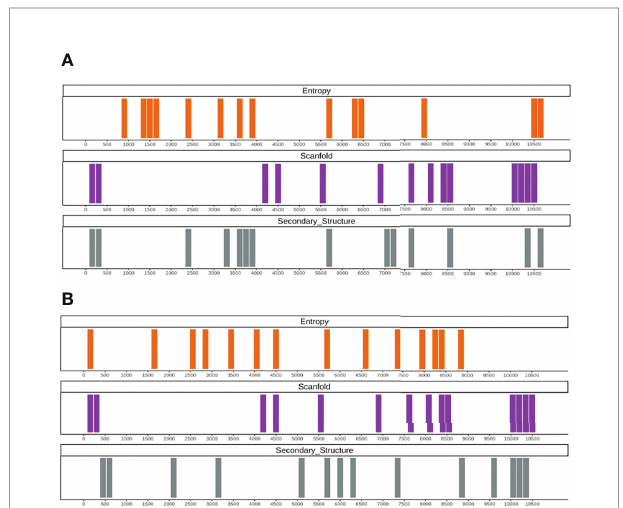
FIGURE 5 | (A) Outputexampleofthe RNAvigator pipelineforthecompleteXIST showingthebottom20%ofregionsforSHAPEreactivity(Secondary_Structure; gray), Scanfold z-score(Scanfold;purple),andtheentropyobtainedbyusingSHAPE dataasinputinside Superfold (Entropy;orange).Notoriousrepetitiveregions(Rep) arehighlightedonthetop. (B) Outputexampleofthe RNAvigator pipelineforthe completeXISTgenomeshowingthebottom20%ofregionsfor CROSS predictions (Secondary_Structure;gray), Scanfold z-score(Scanfold;purple),andtheentropy obtainedbyusing CROSS SHAPE-likedataasinputinside Superfold (Entropy;